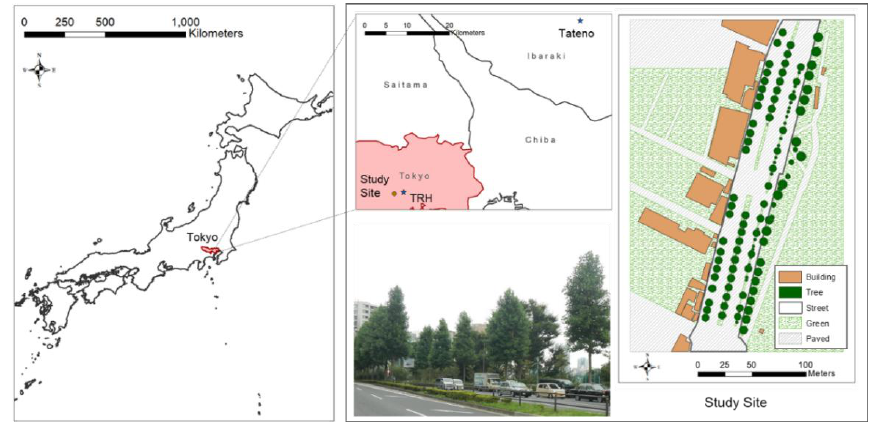
Figure 3. Study site along 2020 Tokyo Olympic marathon course in Tokyo, Japan; photograph taken northward from southern end of site, showing Yurinoki—tulip tree (Liriodendron tulipifera). Using D-COMFA, hourly EB including each energy component in Equation (1) were estimated on a 1 m cell basis for 9 August 2016 (the hottest day of the year) from 7 a.m. to 6 p.m. was assumed that the estimated EB is for a spectator wearing a T-shirt, regular walking shorts, socks, and shoes that represent clothing resistance, R co = 77 (s m −1 ) [31] that is equal to 0.41 clo (1 clo = 186.6 sm −1 ) [33] and